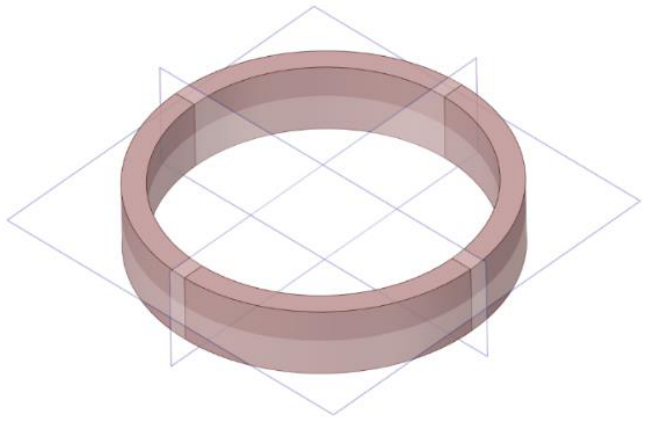
Figure 4. Symmetry planes of the fiber-optic coil.